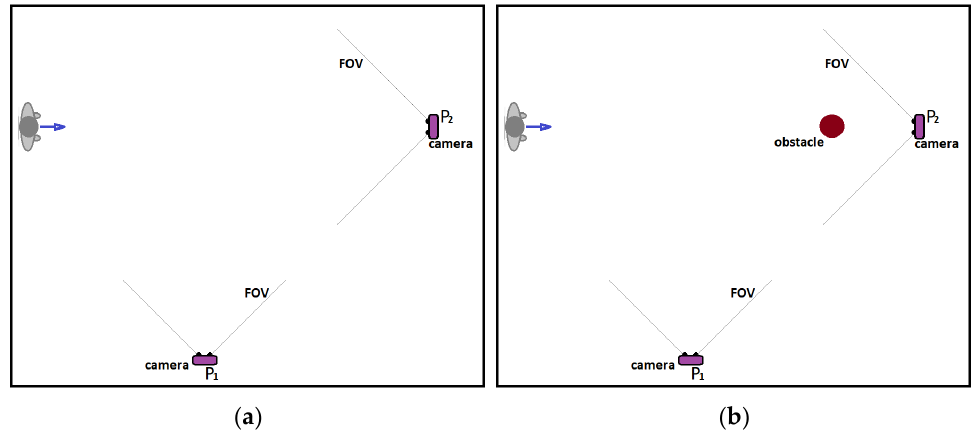
Figure 3. Setup used to assess the gait parameters of the subjects: ( a ) in a free walk and ( b ) in a walk with an obstacle to be avoided.